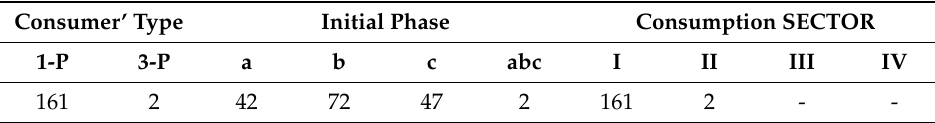
Table 5. Synthesis on the characteristics of the consumers from the analyzed